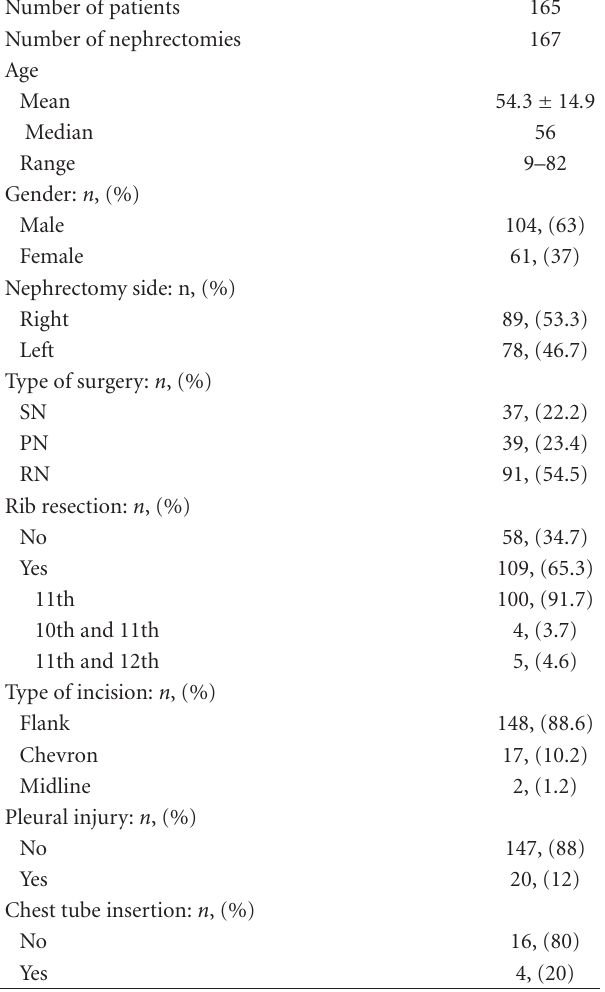
Table 2: Characteristics of patients included in our